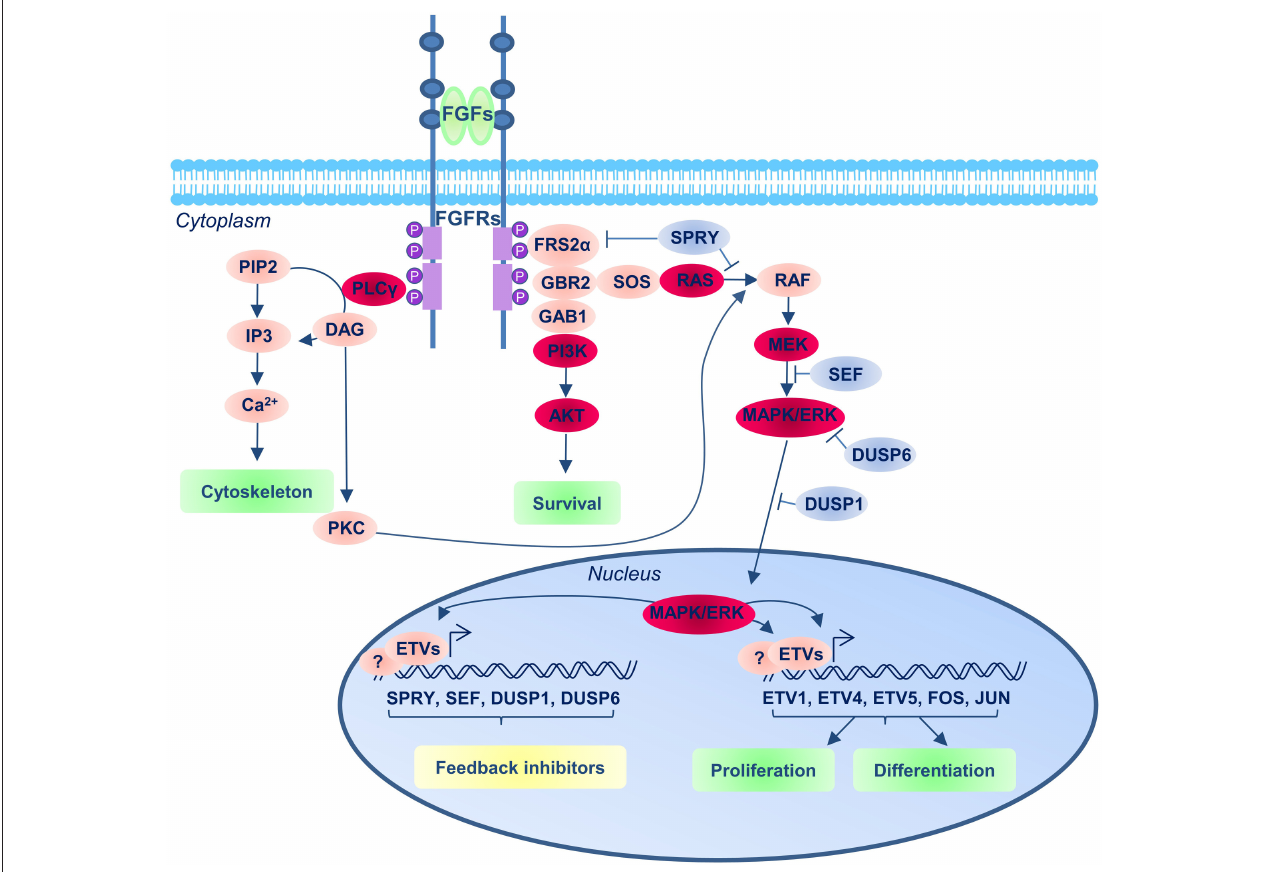
FIGURE 2 | FGF signaling pathway. The FGFRs consist of three extracellular immunoglobulin-type domains (D1–D3; blue balls in the receptor), a single-span trans-membrane domain and an intracellular split domain. FGFs interact with the D2 and D3 domains, and promote upon binding receptor dimerization and tyrosine kinase autophosphorylation of the FGFRs that results in the recruitment and assembly of signaling complexes. The main three downstream FGF/FGFR signaling complexes operating in the context of neural development are represented (the red balloons indicate the main components of the pathway): the Ras/MEK/MAPK/ERK; the PI3K/AKT and the PLC γ pathways. The blue balloons indicate the repressor regulators of the